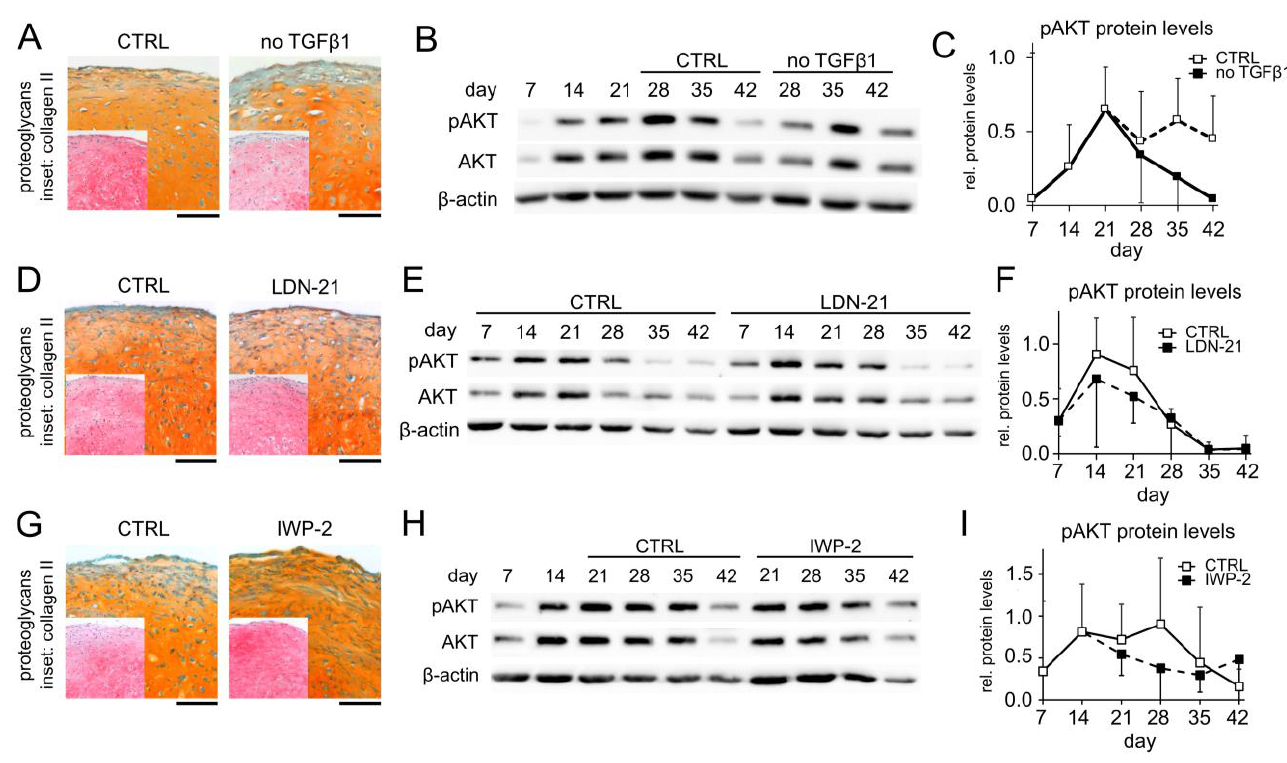
Figure 2. Elevated AKT activation is independent of TGF β and cell-autonomous BMP and WNT activity. MSC pellets were subjected to chondrogenic culture for 6 weeks and the effects of TGF β , BMP, and WNT signaling on AKT activation were investigated. ( A – C ) TGF β 1 treatment was discontinued from day 21 on in the treatment groups (no TGF β 1), whereas control pellets received 10 ng/mL TGF β 1 throughout 6 weeks of pellet culture (CTRL). ( D – F ) 500 nM of the BMP inhibitor LDN-212854 (LDN-21) or 0.02% DMSO solvent (CTRL) was applied from day 0 on. ( G – I ) MSC pellets were treated with 2 µ M IWP-2 or 0.04% DMSO solvent (CTRL) from day 14 on. ( A , D , G ) Paraffin sections of day 42 MSC pellets were stained with Safranin O/Fast Green to visualize proteoglycan deposition and by immunohistochemistry to visualize type II collagen (insets). Scale bars: 100 µ m for proteoglycans and 200 µ m for type II collagen. ( B , C , E , F , H , I ) Western blot detection of pAKT and AKT protein levels using β -actin as loading control. Medians ± 95% confidence intervals are shown; n = 3 – 5.